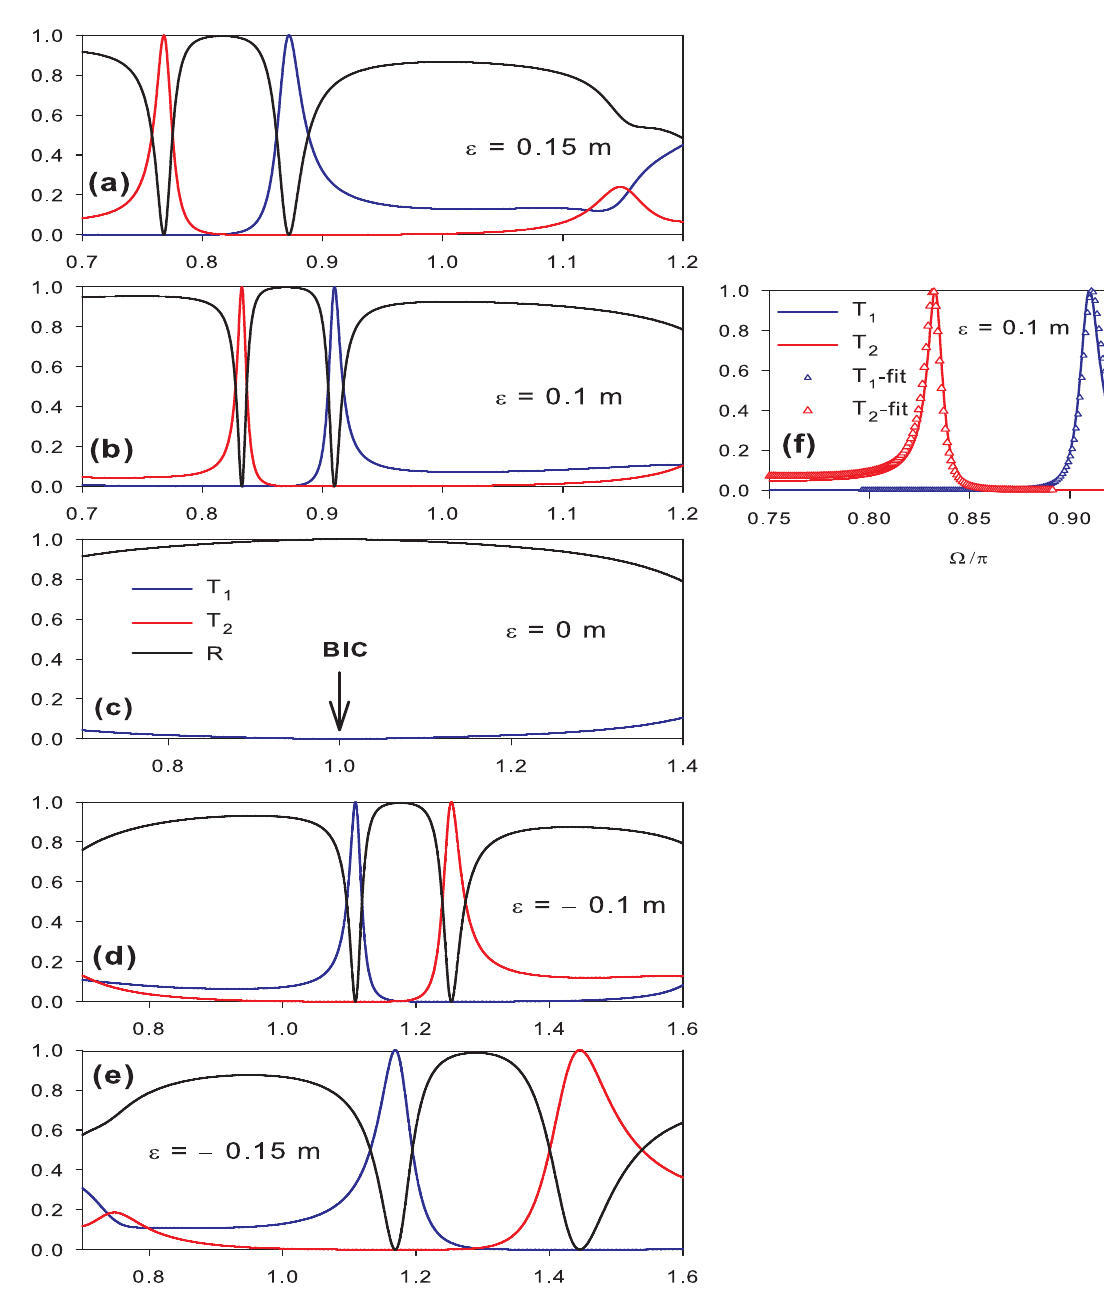
Figure 2. ( a – e ) Variation of the intensity of the transmitted signal in line 1 (blue lines), line 2 (red lines) and the reflected signal at the input of the demultiplexer (black lines) versus the dimensionless frequency Ω / π for different values of ε and for d 0 = 1 m. The other lengths are chosen according to Equations (5)–(9). ( f ) The fitted results (open triangles) of the Fano resonances in ( b ) obtained by the Fano formula in Equation (10). The arrow in ( c ) indicates the position of BIC